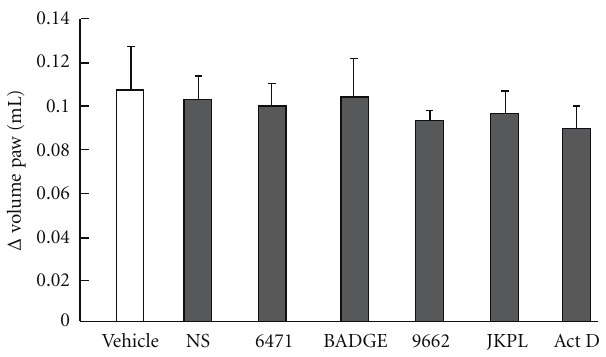
Figure 7: Influence of reagents on edema induced by carrageenan . BADGE was injected intraperitoneal 30min before carrageenan injection at doses of 30 mg/kg. NS-4TF (30 μ g/paw), GW6471 (30 μ g/paw), BADGE (30mg/kg), GW9662 (10 μ g/paw) and JKPL- 85 (30 μ g/paw), were injected into subplantar 15min before car- rageenan injection. The vehicle group received physiological saline including 10% dimethylsulphoxide. Each column and vertical bar represents the means ± S.E.M. ( n =